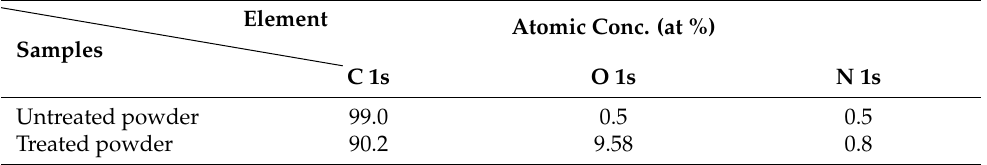
Table 1. XPS atomic composition summary for LDPE samples.